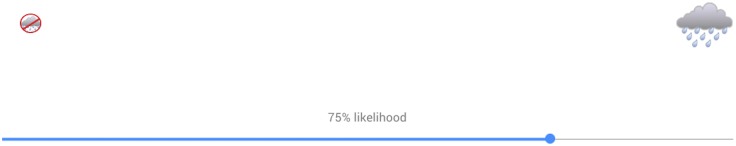
Example of touchscreen application (slider method).The Figure represents the slider method when asking the respondents about the likelihood that it will rain tomorrow.